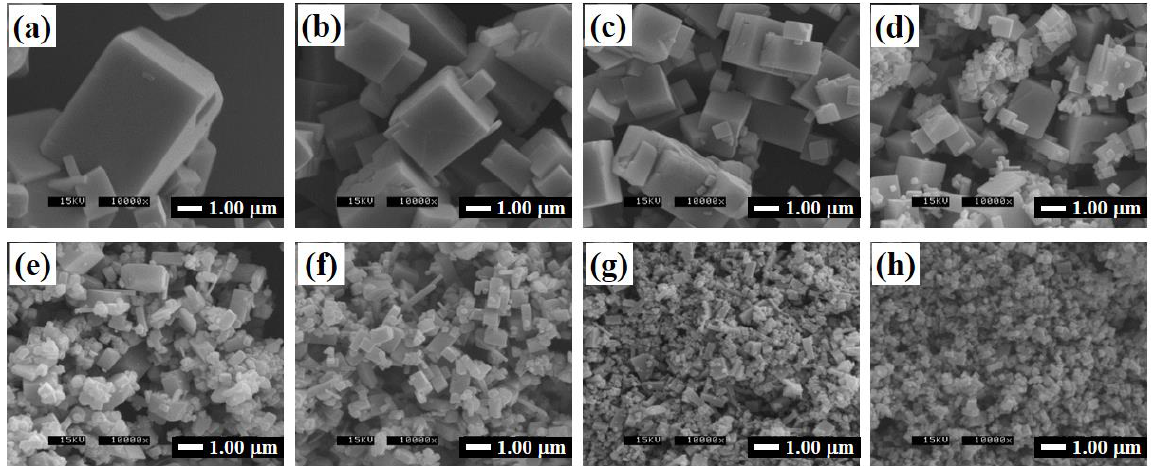
Figure 6. FE-SEM photomicrographs of KNN particles synthesized by glycothermal treatment with various solvent volume ratios of B/W at 200 °C for 12 h: ( a ) 0/70 (pure hydrothermal), ( b ) 10/60, ( c ) 20/50, ( d ) 30/40, ( e ) 40/30, ( f ) 50/20, ( g ) 60/10, and ( h ) 70/0 (pure glycothermal).